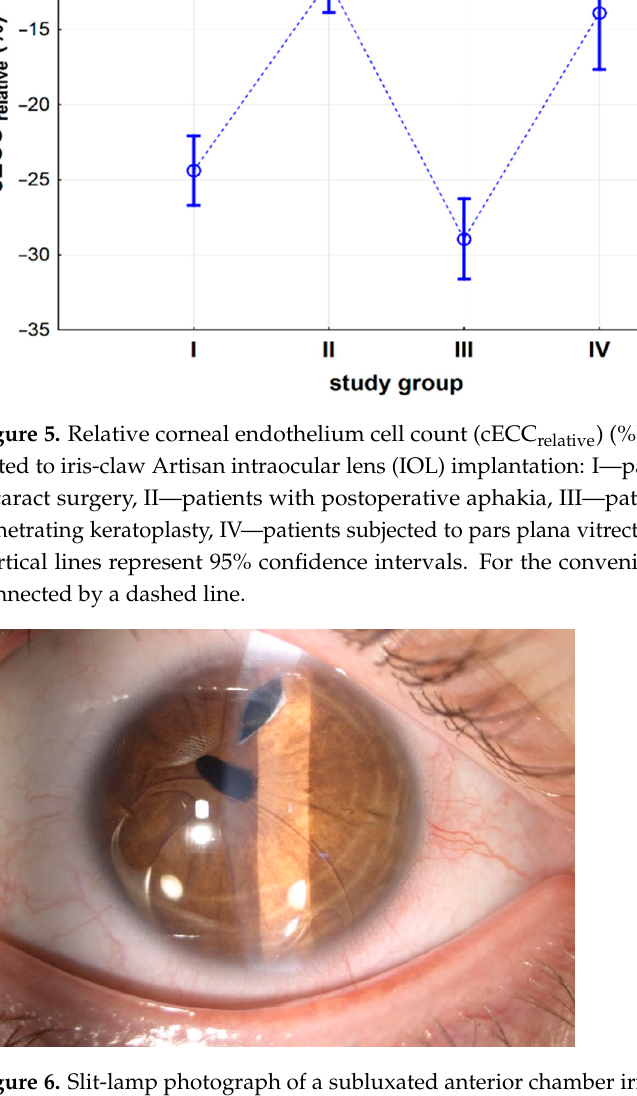
Figure 5. Relative corneal endothelium cell count (cECC relative ) (%) in four groups of patients sub- jected to iris-claw Artisan intraocular lens (IOL) implantation: I—patients subjected to complicated cataract surgery, II—patients with postoperative aphakia, III—patients with aphakia subjected to penetrating keratoplasty, IV—patients subjected to pars plana vitrectomy and luxated IOL extrac- tion. Vertical lines represent 95% confidence intervals. For the convenience of the reader, the dots are connected by a dashed line.